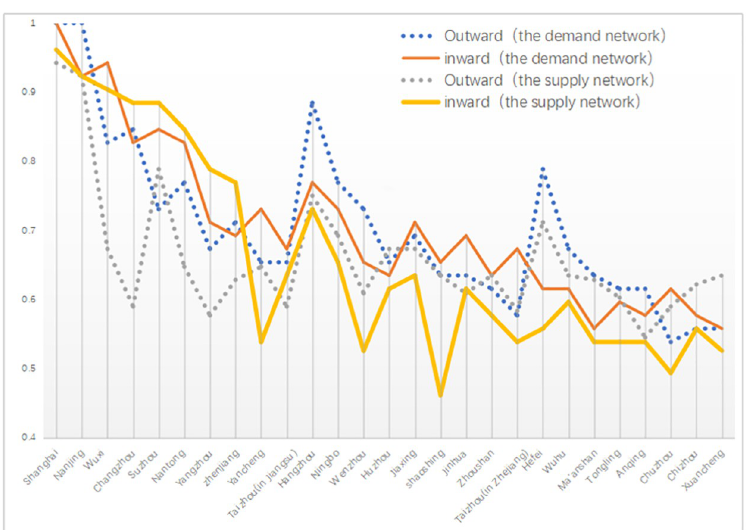
Fig 5. The closeness centrality indexes of supply and demand networks in regional tourism